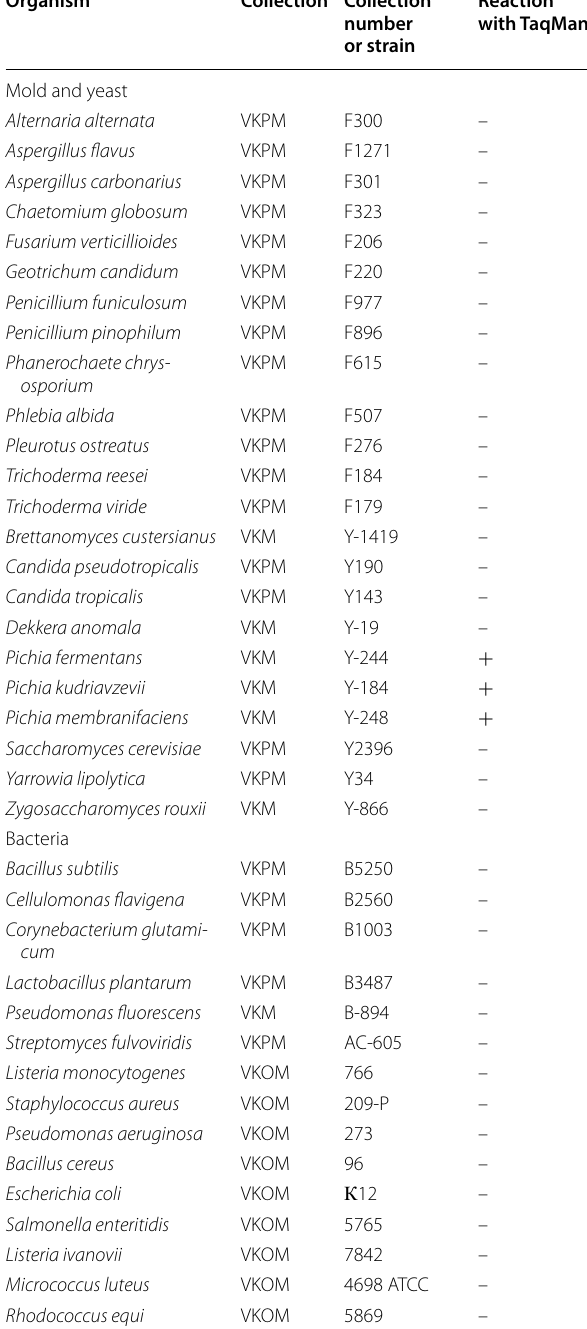
Table 2 Verification of the specificity of the developed method with microorganisms from different taxonomic